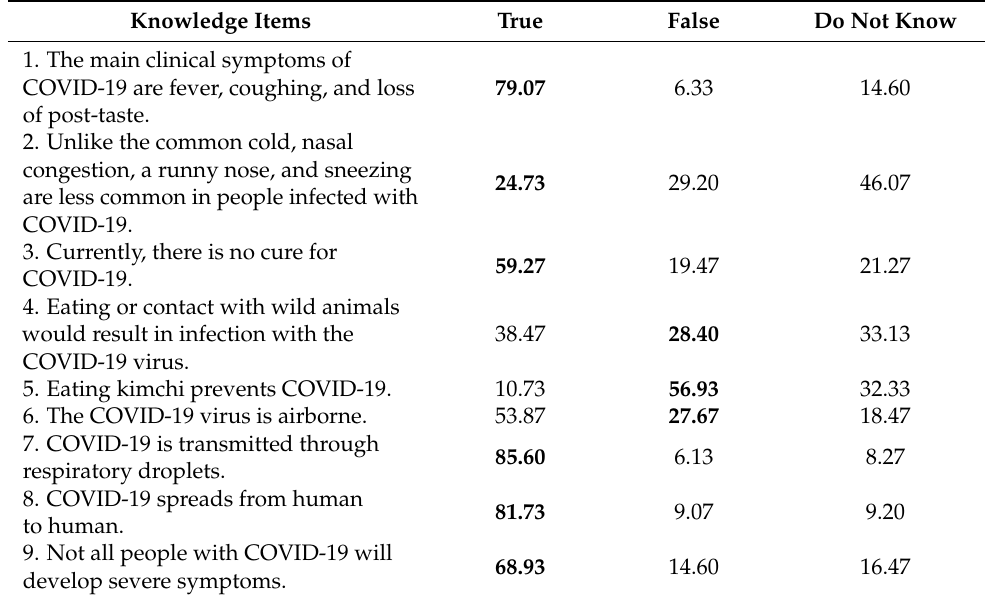
Table 1. Responses to knowledge item